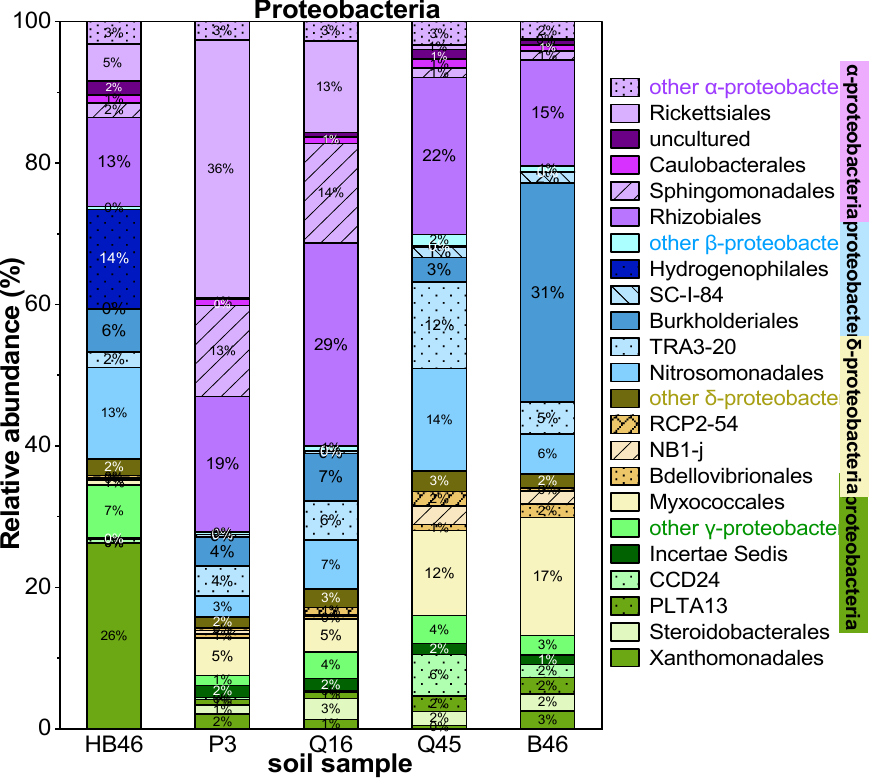
Figure 3. Relative abundance of orders belonging to the phylum Proteobacteria in each soil bacterial community based on the NGS. These orders can be grouped into class alpha-, beta- delta- and gamma-proteobacteria.